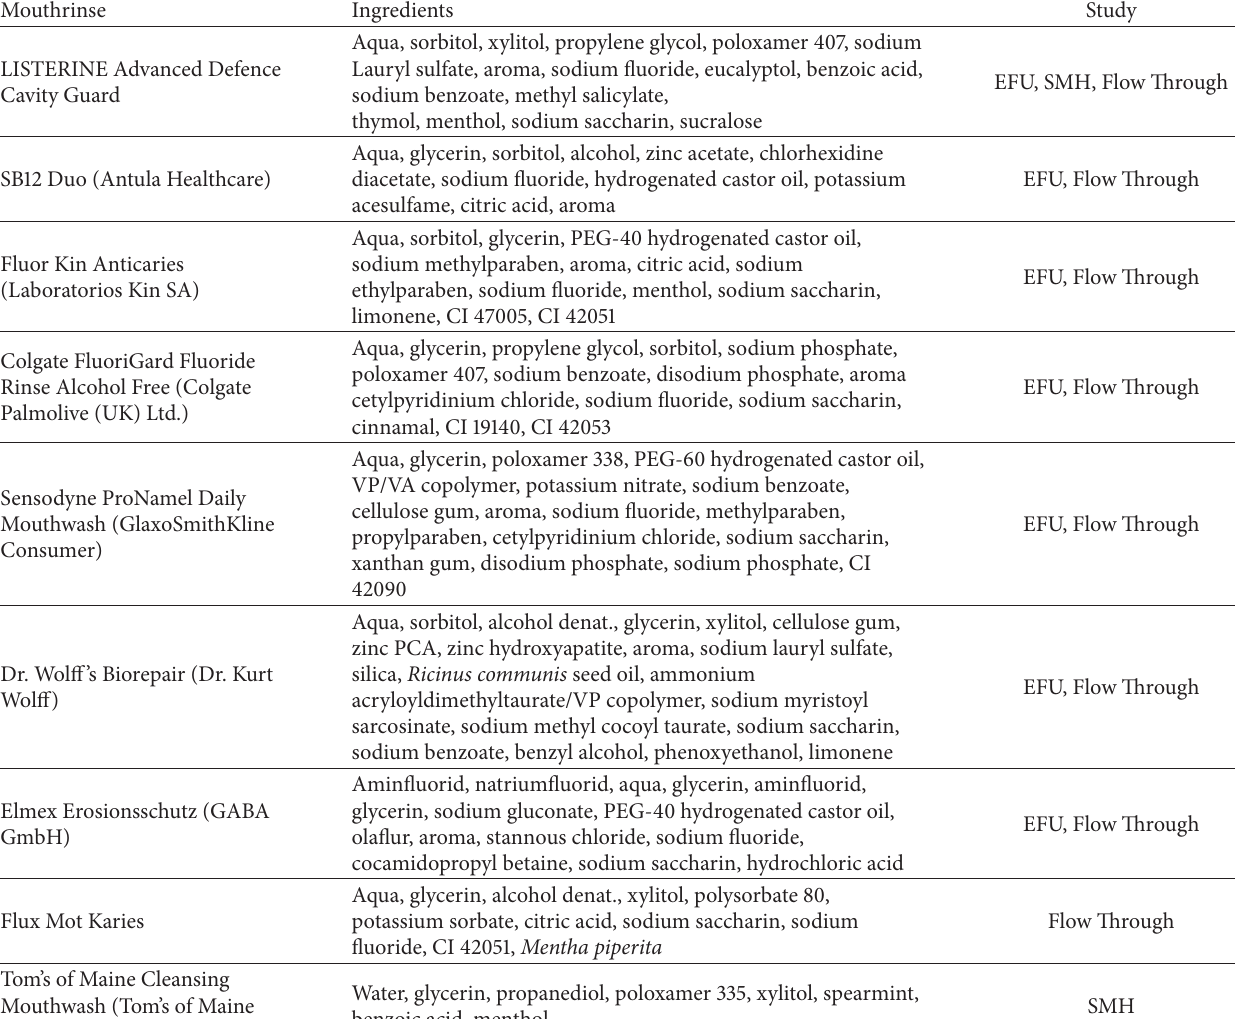
Table 1: Mouthrinses used in the different